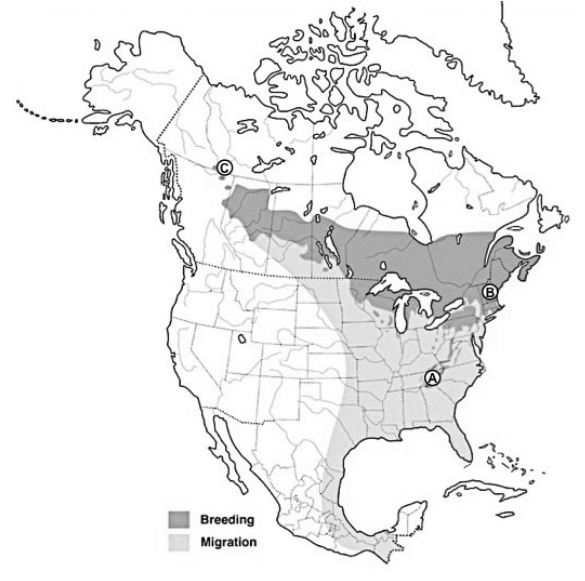
Fig. 1 . Distribution map of the breeding and migratory range for Canada Warblers ( Cardellina canadensis ). Sample collection sites are indicated on map with lettered circles: (A) Coweeta, North Carolina, USA; (B) Canaan, New Hampshire, USA; (C) Fort Liard, Northwest Territories, Canada. (Map from The Birds of North America https://birdsna.org; used with